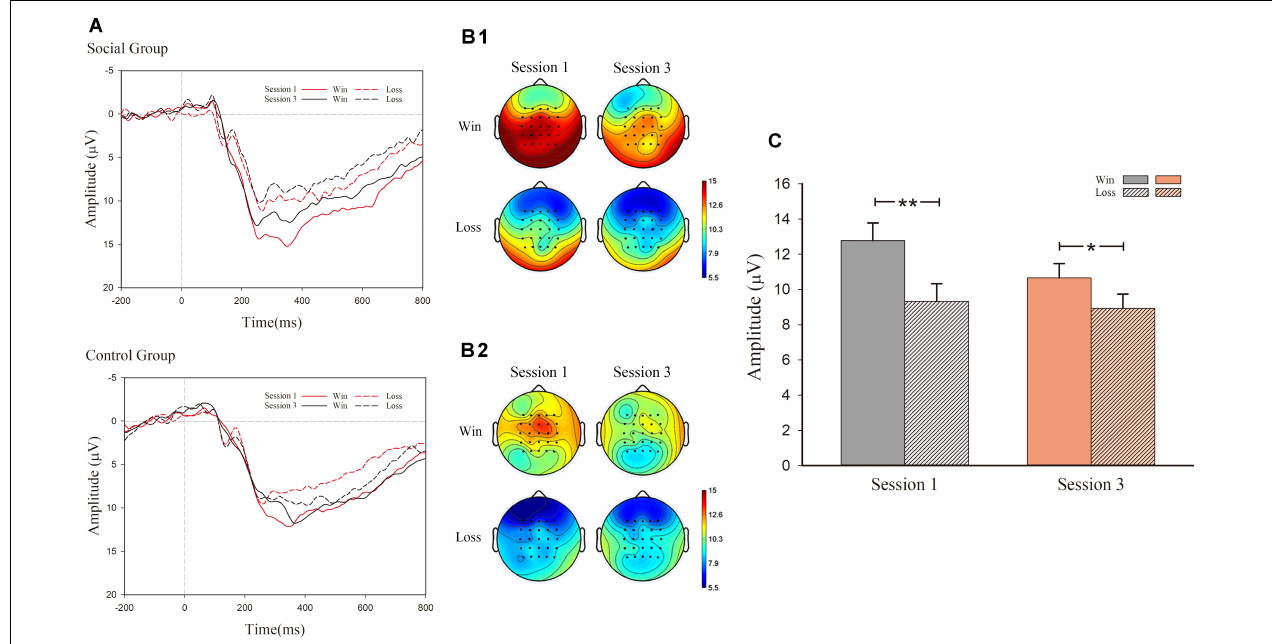
FIGURE 4 | ERP results for P300. (A) Grand-average ERP waveforms of P300 from the average voltage of all the electrodes were plotted as a function of session (first and third) and outcome (success and failure); (B1) P300 topography map of the social group; (B2) P300 topography map of the control group; (C) mean voltage of P300